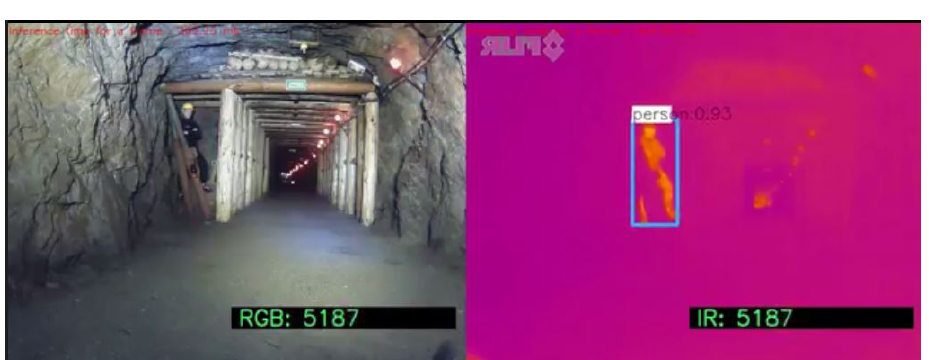
Figure 16. Human obscured—no detection in RGB image, correct detection in the IR image with algorithm YOLO.